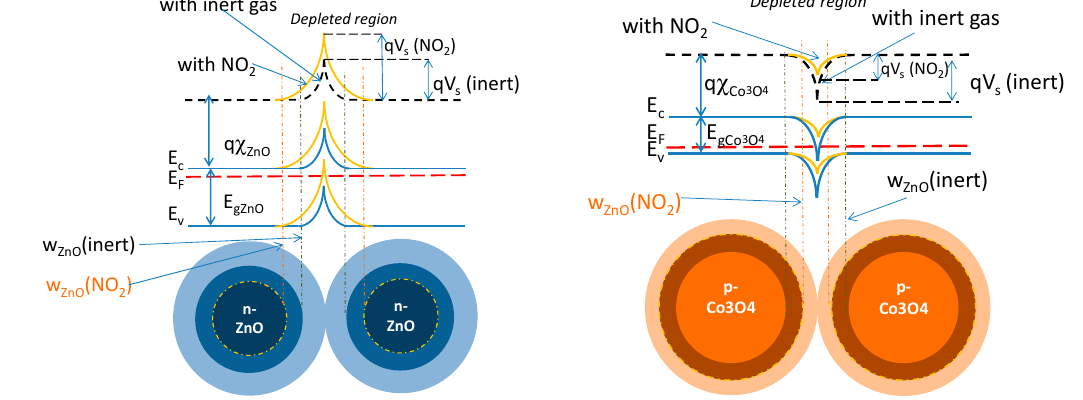
Figure 6. Schottky barrier formation and the effect of an oxidizing gas.